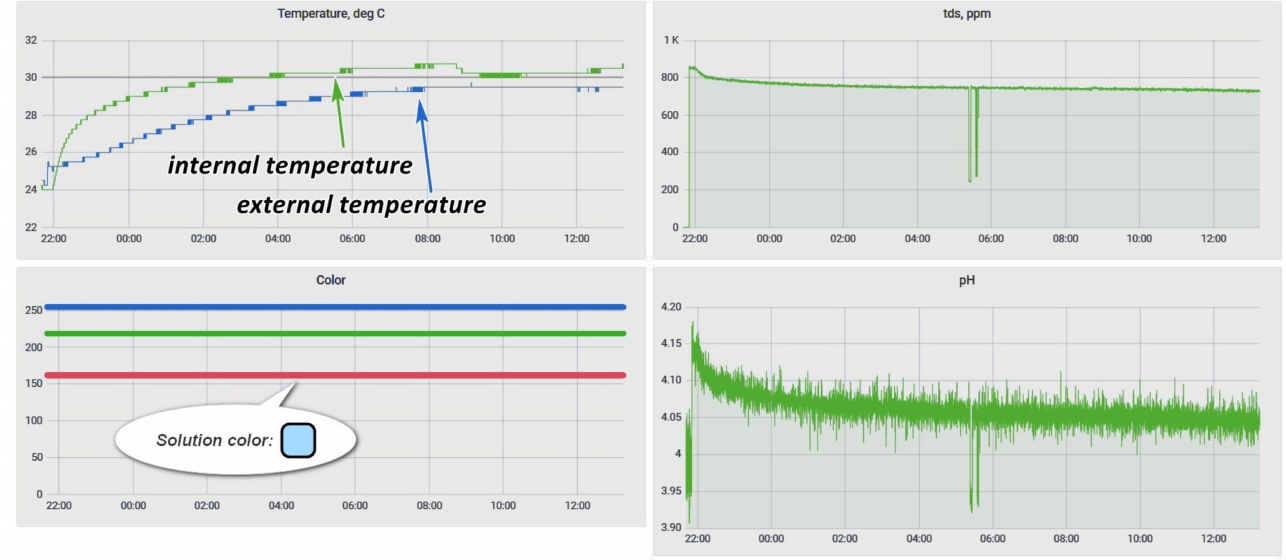
Figure 14. Grafana etching process monitoring